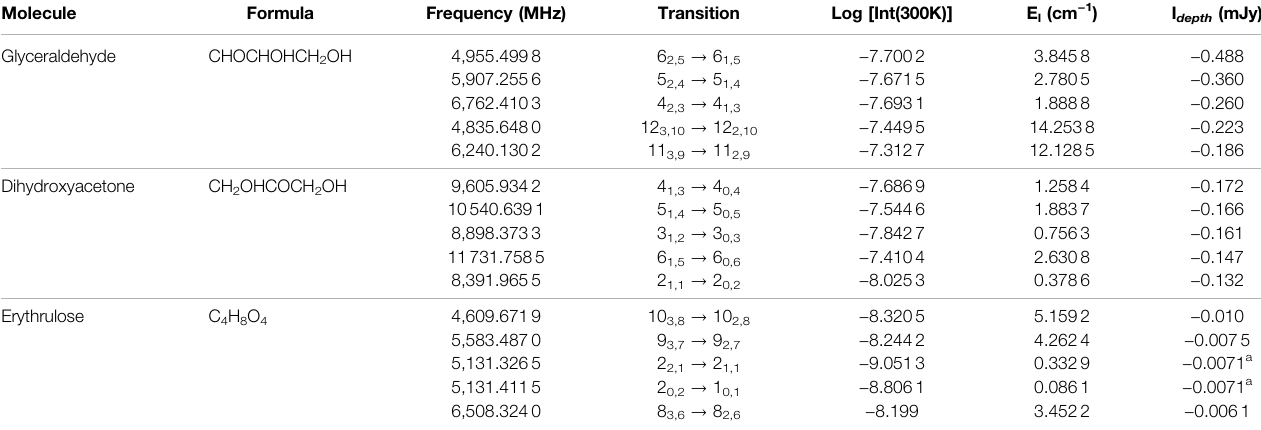
TABLE 1 | List of transitions of glyceraldehyde, dihydroxyacetone and erythrulose that present the deepest features in the simulated spectra.